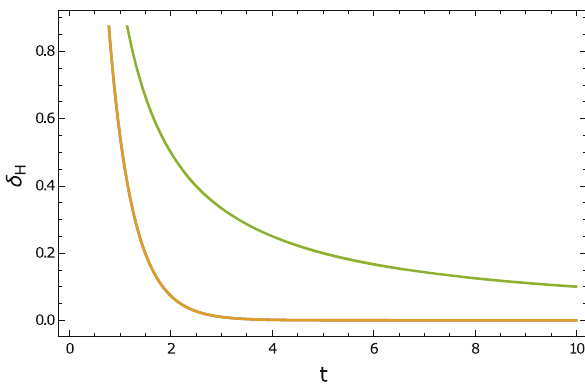
Fig. 10 Evolution of perturbation of matter overdensity as a function of cosmic time. The blue curve represents the constant jerk parameter model reconstruction. The yellow curve represents the variable jerk parameter model reconstruction where jerk parameter j ∼ 1 blue curve shows the evolution for the reconstructed models from a slowly varying jerk